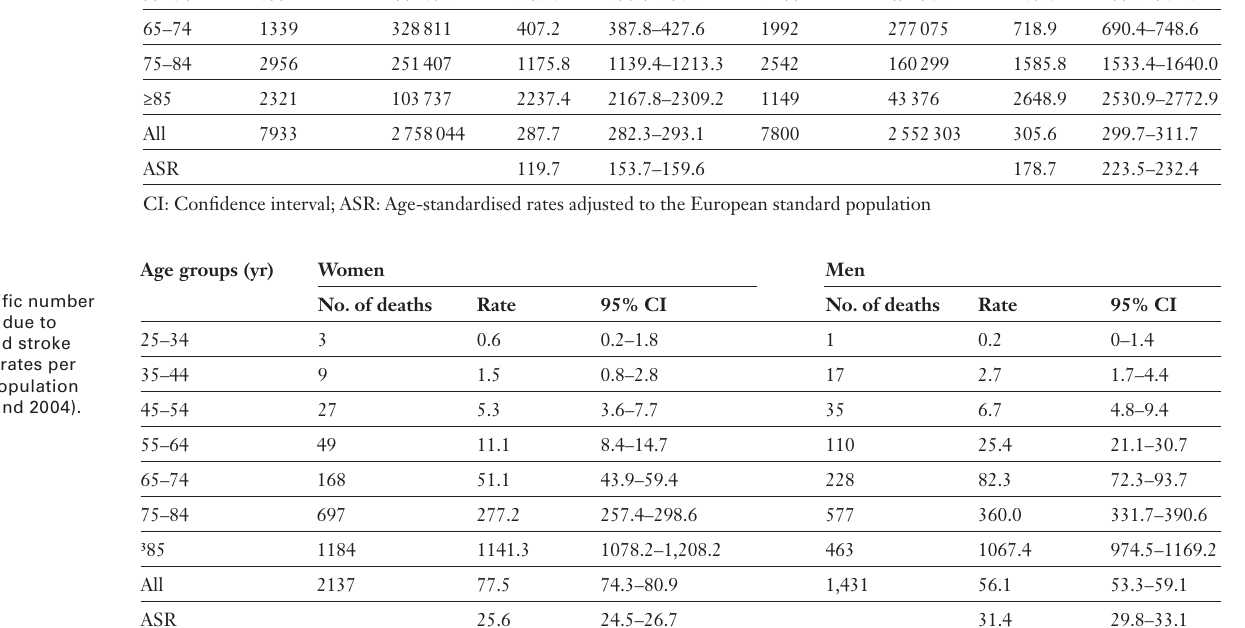
Estimated age-spe- cific and total stroke events (absolute number of cases, and rate per 100000 population) (Switzer-